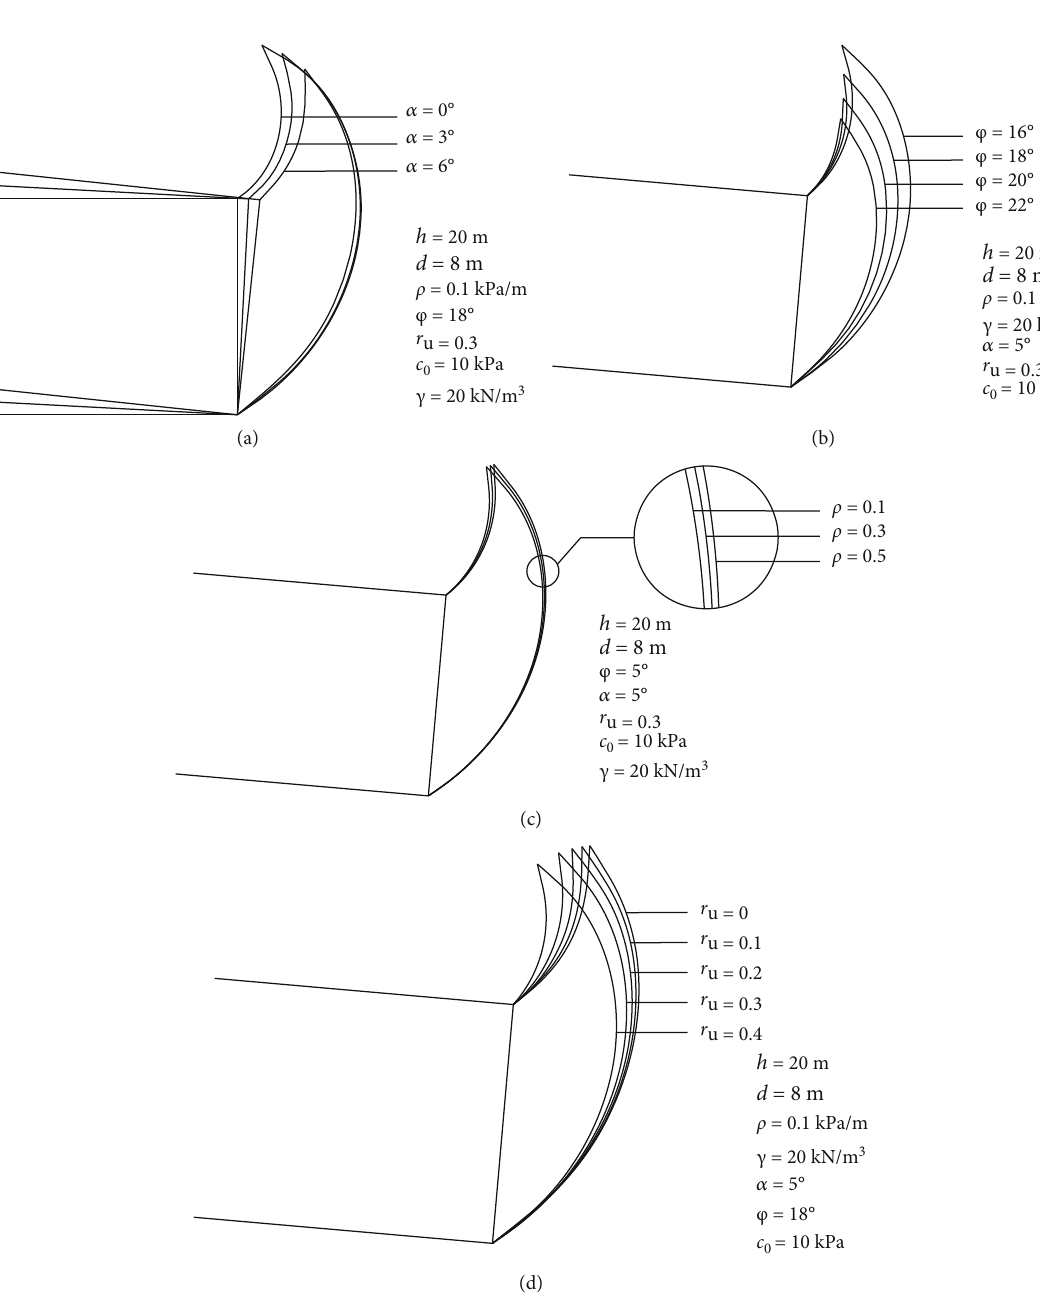
Figure 4: In fl uence of parameters on the position of failure surface: (a) tunnel inclination angle α ; (b) internal friction angle φ ; (c) coe ffi cient of soil heterogeneity ρ ; and (d) pore water pressure coe ffi cient r u